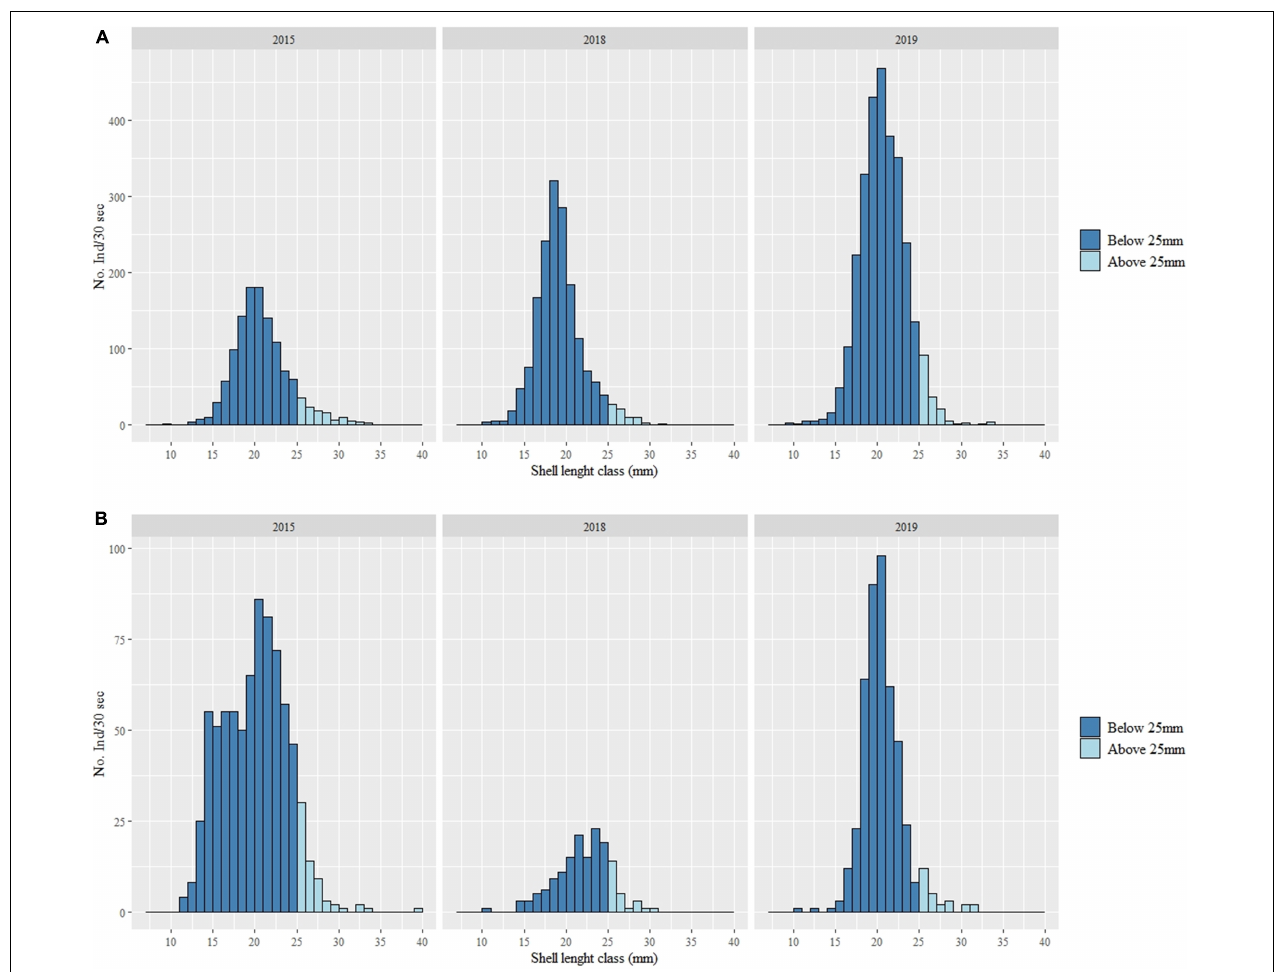
FIGURE 4 | Shell length-frequency distribution of Cerastoderma spp. in the Tagus estuary (A) and Sado estuary (B) , in the years 2015, 2018, and 2019. The dark blue bars represent the shell length classes below the minimum catch size (25